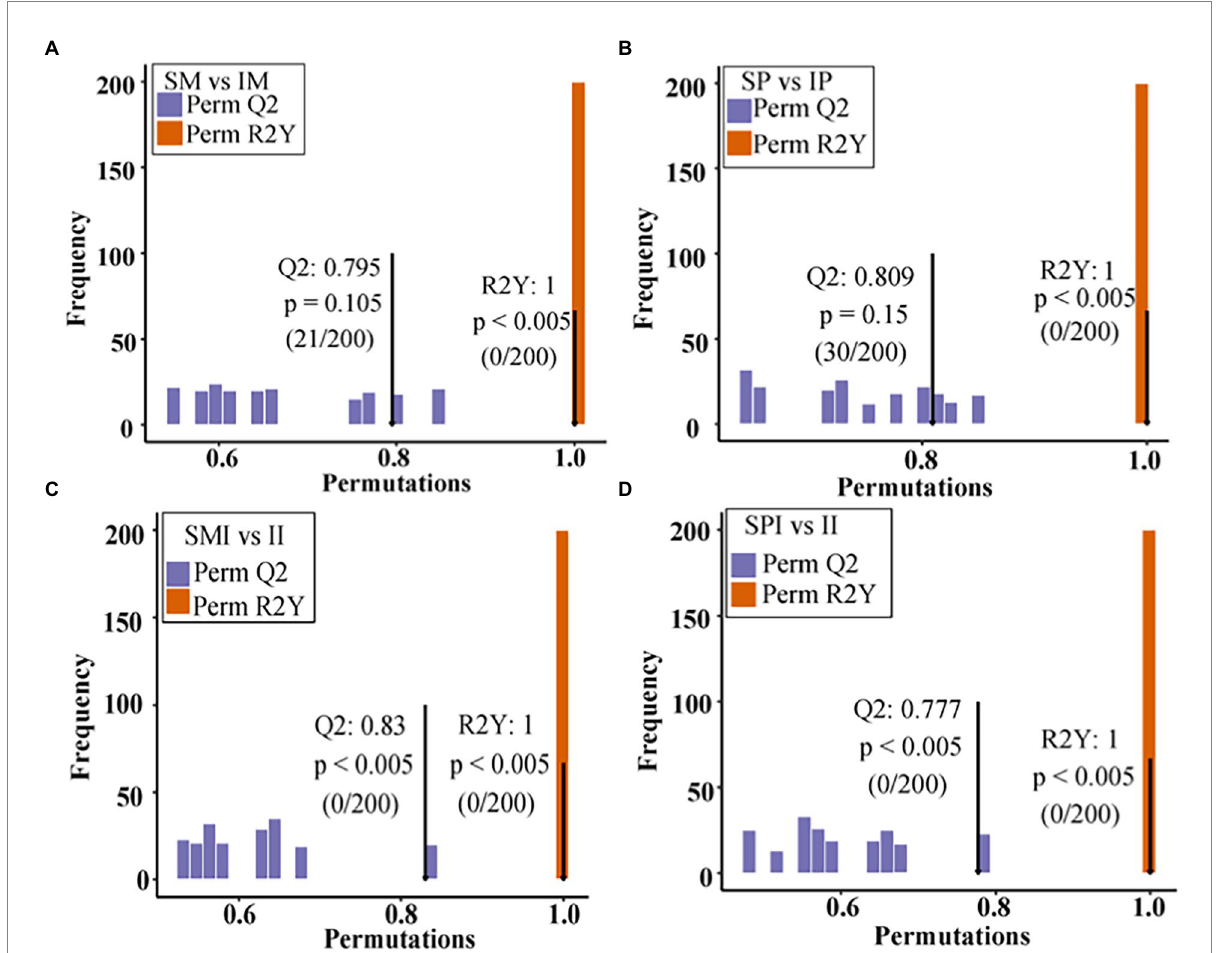
FIGURE 3 OPLS-DA models of maize and peanut root exudates under different planting patterns. (A) SM vs. IM, (B) SP vs. IP, (C) SMI vs. II, (D) SPI vs. II. X: the accuracy of the model, Y: the frequency of the model classification effect. SM: sole maize, IM: intercropped maize, SP: sole peanut, IP: intercropped peanut, SMI: the shared soil of sole maize, SPI: the shared soil of sole peanut, II: the shared soil of intercropped maize and